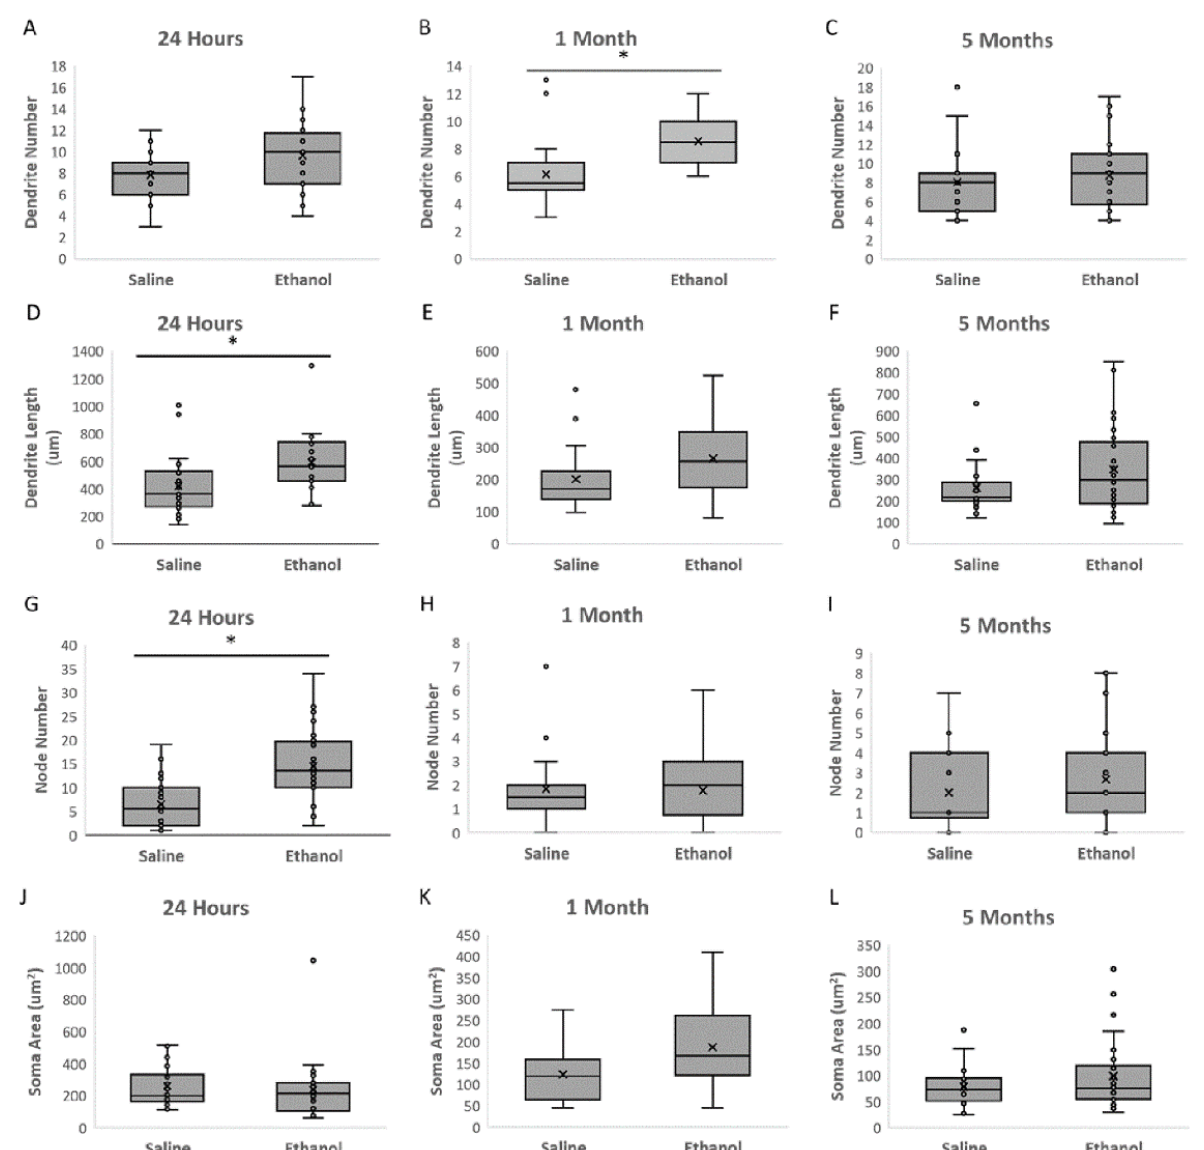
Figure 2. Ethanol treatment during synaptogenesis significantly increases MSN dendritic length and number of nodes after 24 h. ( A – C ). Dendritic number was significantly greater in ethanol-treated animals 1 month after exposure ( B ); p = 0.002), and it trended towards significance at 24 h ( A ); p = 0.065). There was not enough statistical power to conclude that ethanol did not affect dendrite number at 5 months of age ( C ); Power: 0.717). ( D – F ). Dendritic length was